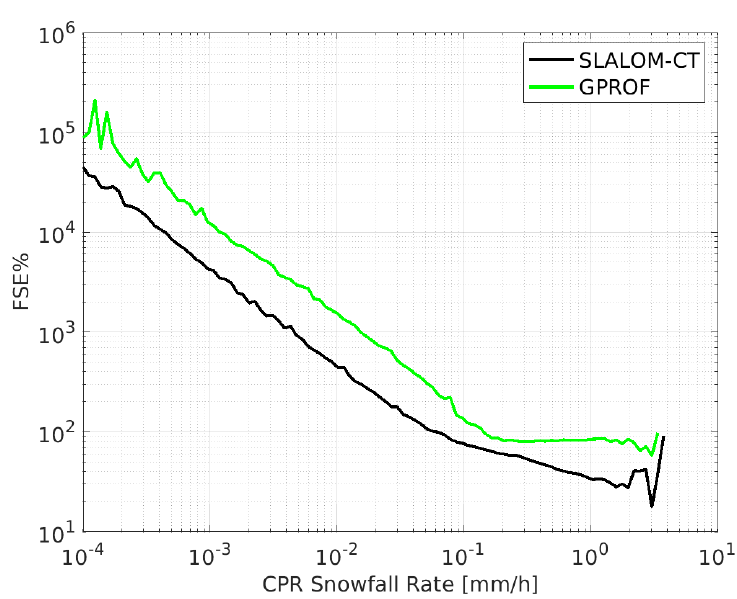
Figure 11. Fractional standard error percentage (FSE%) of SLALOM-CT and GPROF as a function of CPR snowfall rate, over snow-covered surfaces.